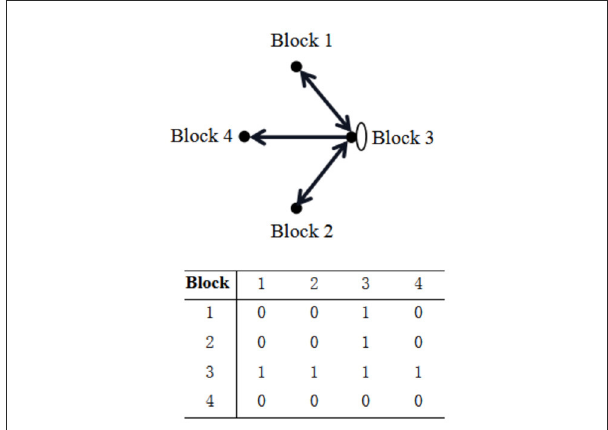
FIGURE3 Relationship between the blocks of China’s low-carbon cooperation network in 2021 and the image matrix.